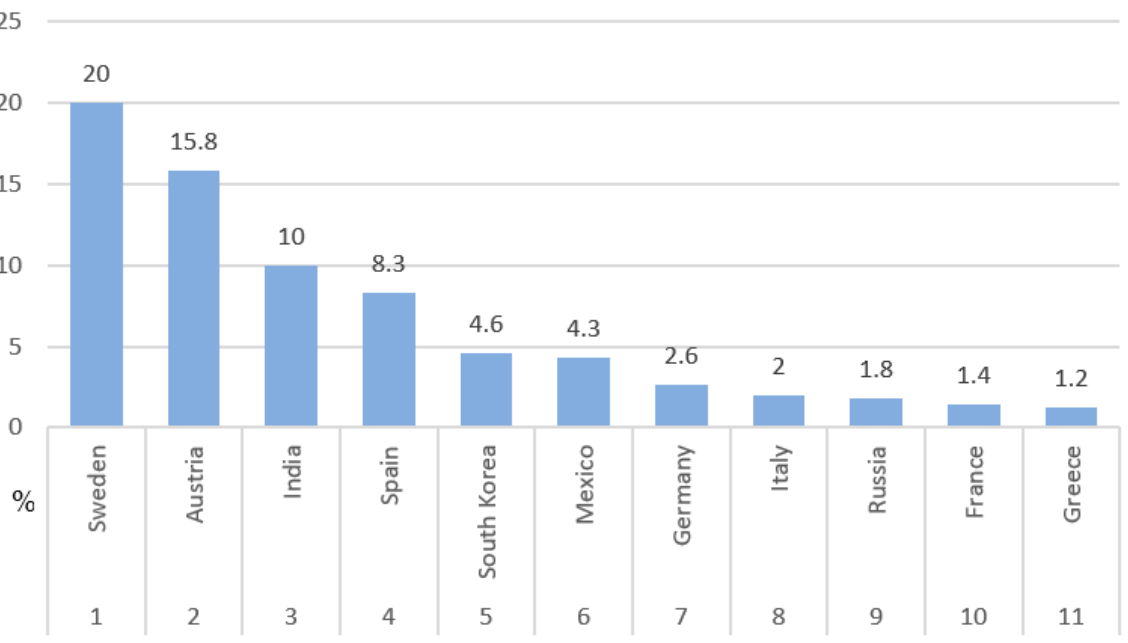
Figure 4. Ranking of OECD countries and OECD key partner countries by the share of tax